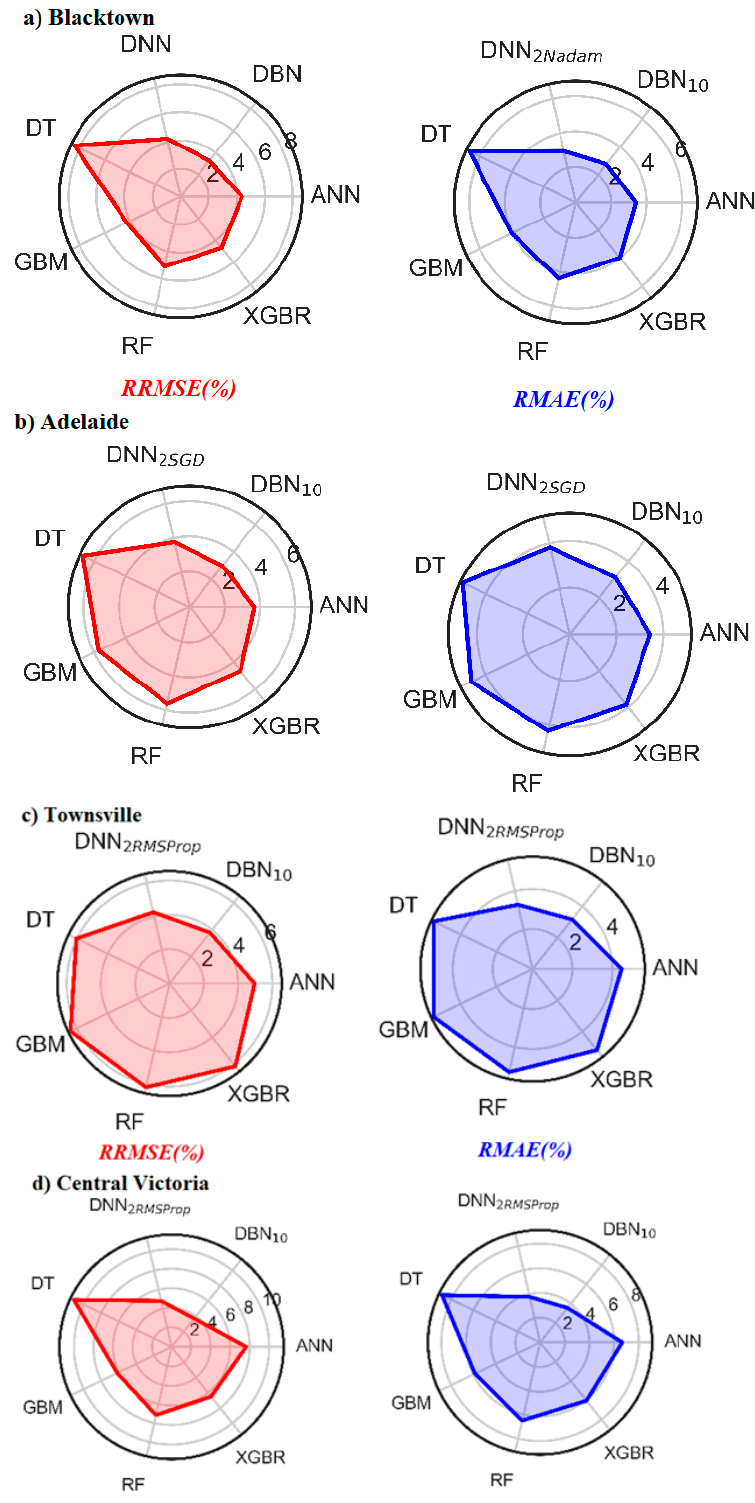
Figure 4. Radar plots in the model’s testing phase for prediction of GSR , in terms of the relative root mean squared error ( RRMSE %) and relative mean absolute error ( RMAE %).